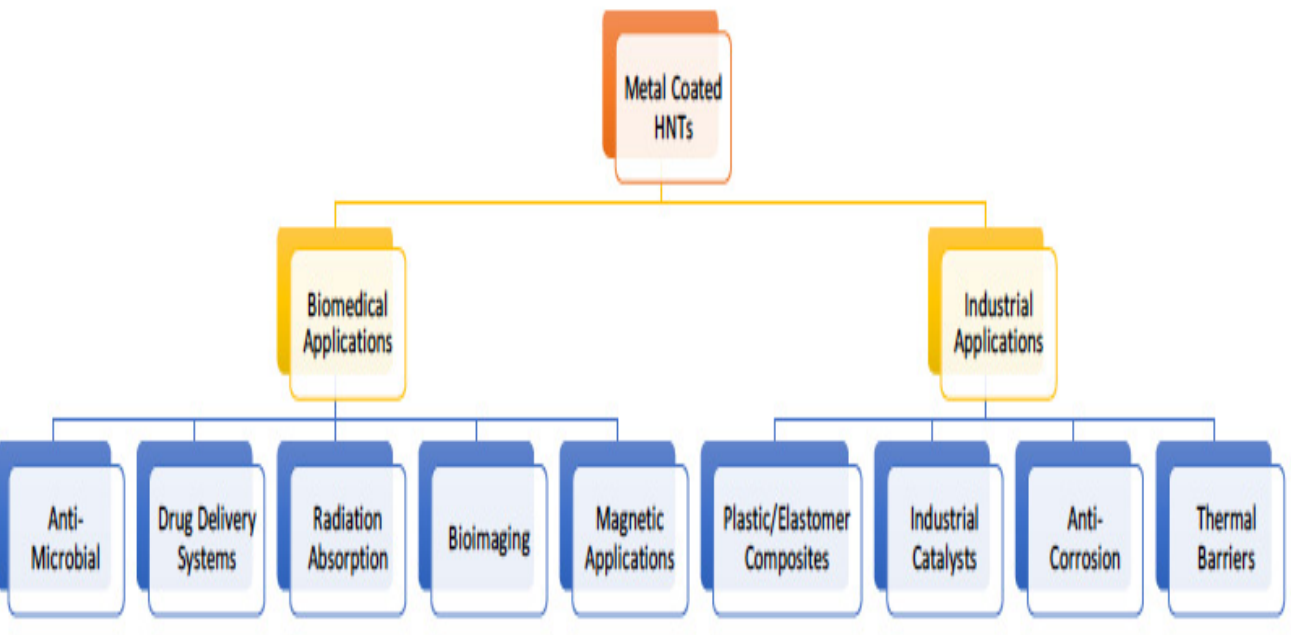
Figure 6. Biomedical and industrial applications of metallized HNTs.